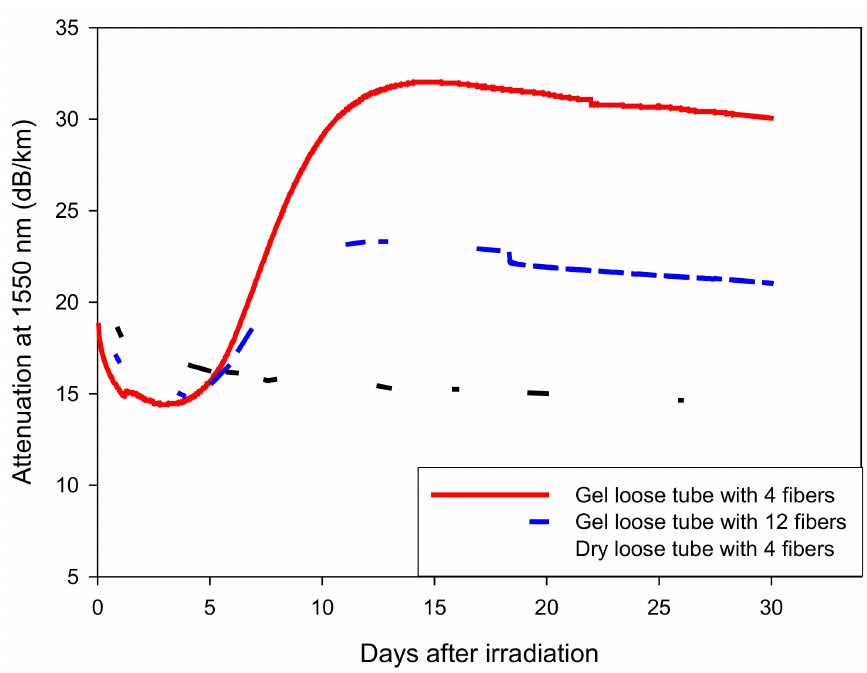
Figure 4. Influence of the gel. Tests were performed on cable samples with the gel (4 or 12 fibres in one tube) and without the gel–dry type with four fibres in a tube. Measurements were not carried out continuously. The test equipment was connected/disconnected for each measurement, which caused small drops and imperfections visible on the